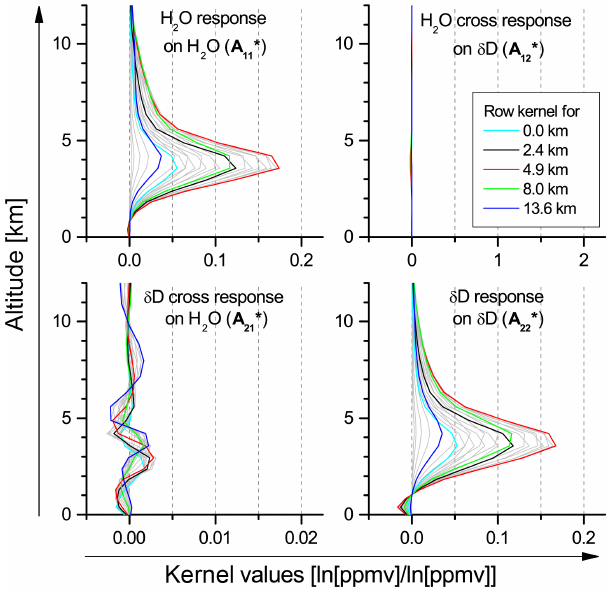
Figure 2. Row entries of the four blocks of the MetOp/IASI full av- eraging kernel matrix in the {H 2 O, δ D} proxy basis system and after a posteriori correction ( A ∗ as given in Eq. 4). It is for a retrieval of an IASI spectrum measured on 11:07UT on 24 Jul 2013 close to the southern coast of Tenerife (the retrieval result of this measurement is one of the data points shown in Fig.